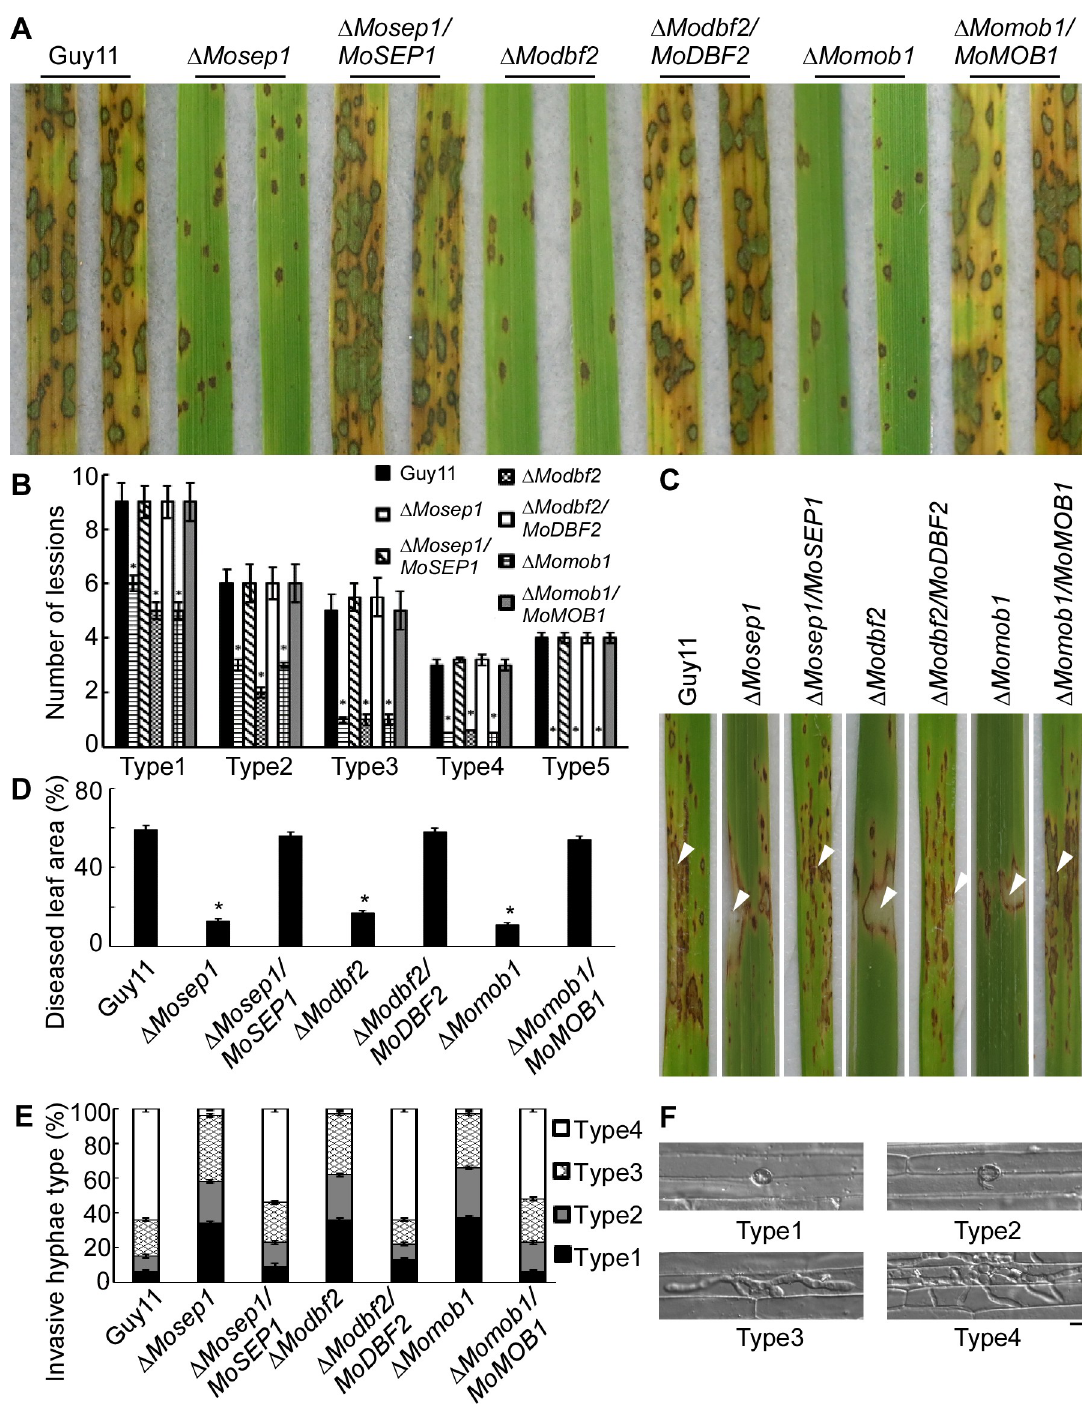
Fig 4. MoSep1, MoDbf2, and MoMob1 contribute to virulence. (A) Pathogenicity assay in rice. Two-week-old rice seedlings were inoculated conidial suspensions of Guy11, the Δ Mosep1 , Δ Modbf2 , Δ Momob1 mutants, and their corresponding complemented strains and photographed at 5 days post-inoculation (dpi). (B) Quantification of lesion types (per 1.5 cm 2 ) on susceptible rice spayed with conidia Guy11, the Δ Mosep1 , Δ Modbf2 , Δ Momob1 mutants, and their corresponding complemented strains. Lesions were quantified by a ‘lesion-type’ scoring assay which divided the lesions into 1–5 types according to their severity (type 1, pinhead-sized dark brown specks without visible centers; type 2, small brown lesions that are approximately 1 mm in diameter; type 3, 2–3 mm gray spots with brown margins; type 4, elliptical gray spots longer than approximately 3–4 mm; type 5, large eyespot lesions that coalesced infecting 50% or